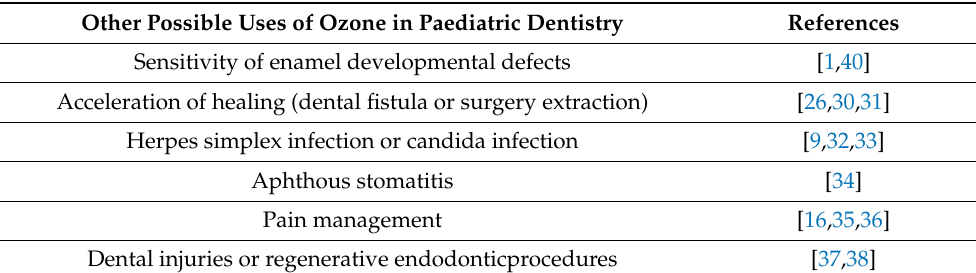
Table 2. Suggested fields of application of ozone therapy in paediatric dentistry that should be further investigated and the related